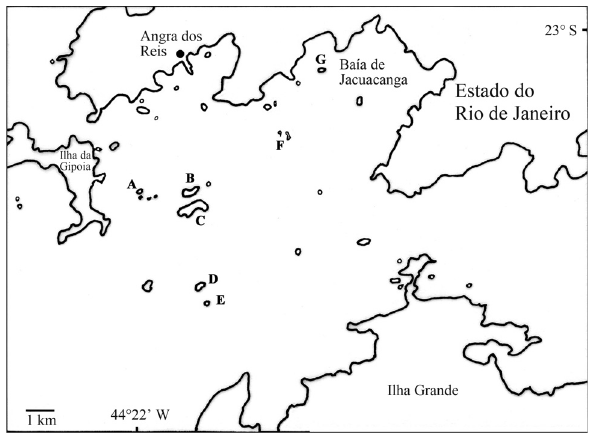
Figure 4 - Localization of the islands near the port of Angra dos Reis where, from 1955 to 1956, the Drosophila willistoni release and capture experiments were carried out: A) São João island; B) Porcos Pequena is- land; C) Porcos Grande island; D) Queimada Grande island; E) Queimada Pequena island; F) Duas Irmãs islands; G) Cavaco island. Redrawn from the nautical map 1636 of the Head Office of Hydrography and Navigation (Brazil. 2004. Port of Angra dos Reis and surroundings, 3 rd ed., Rio de Ja- neiro, Brazilian